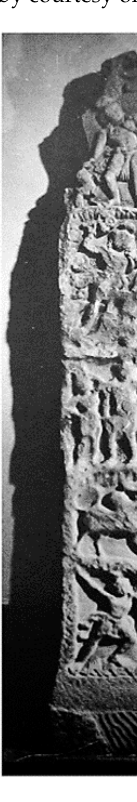
Figure 2. Doorjamb with Exploits of the Young K ṛṣṇ a, fourth–sixth century. Ma ṇḍ or, Rajasthan. Sandstone. Jodhpur Museum (photo by courtesy of the American Institute of Indian Studies).